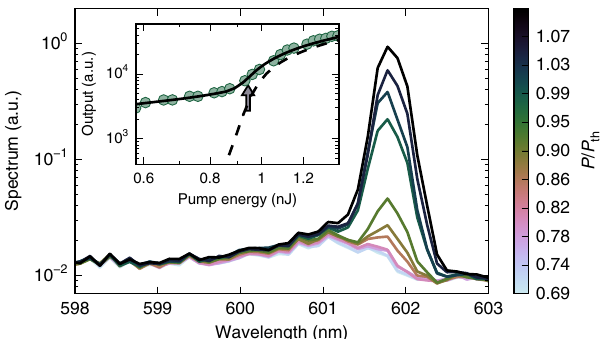
Fig. 2 Spectrum of the cavity output. The fi gure shows spectra above and below the condensation threshold at the critical excitation energy P th . The spectral peak is located at the fundamental mode (ground state) of the cavity, or cavity cutoff, at approximately 602 nm. The inset depicts the total cavity output (dots) and comparison with the single-mode mean- fi eld model, with (full line) and without (dashed line) the contribution from the spontaneous emission background. The arrow indicates the threshold